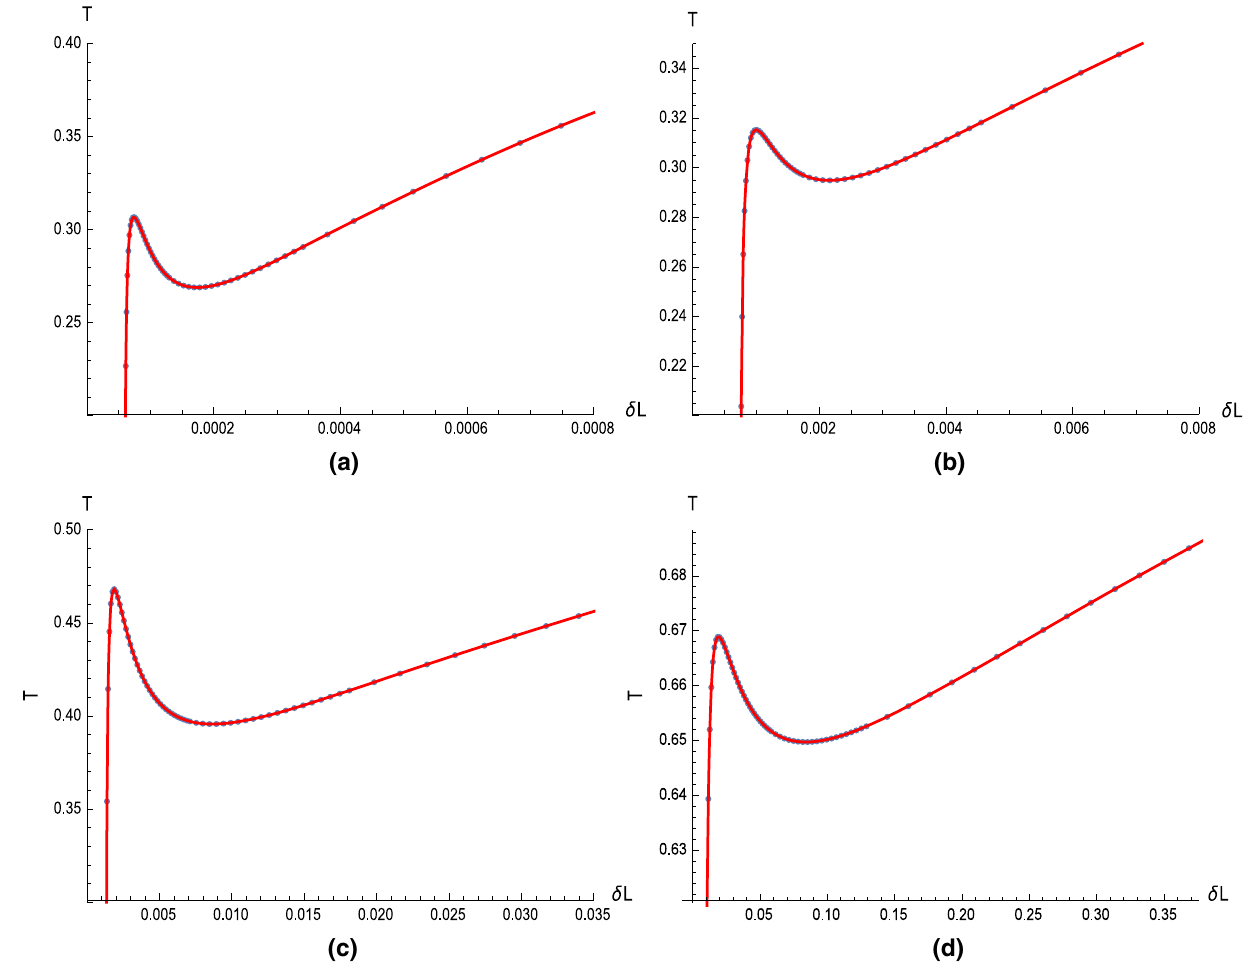
Fig. 1 T vs. δ L for n = 3 ,θ 0 = 0 . 2. a α = 0 , q = 0 . 12, b α = 0 . 25 , q = 0 . 12, c α = 0 . 5 , q = 0 . 06, d α = 0 . 75 , q = 0 . 06